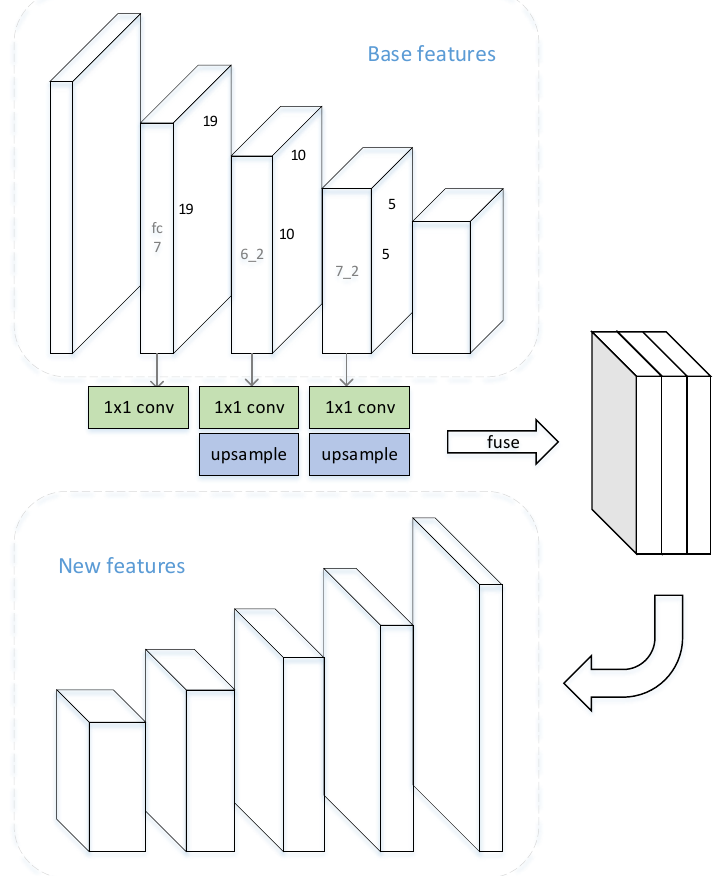
Figure 2. Design of feature fusion module. Top are base features. Three features are selected to be fused. These features are computed through 1 × 1 conv and upsampled into same scale and channel. Following by concatenation to form the aggregation feature. Bottom shows the generated new features from the